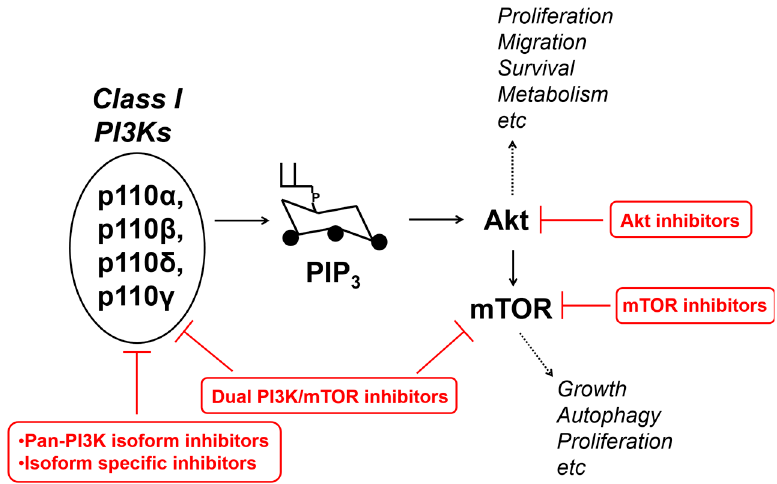
Figure 3. Schematic and simplified representation of the class I PI3Ks/Akt/mTOR pathway, some of the main cellular functions regulated by it, and the main family of inhibitors targeting it.